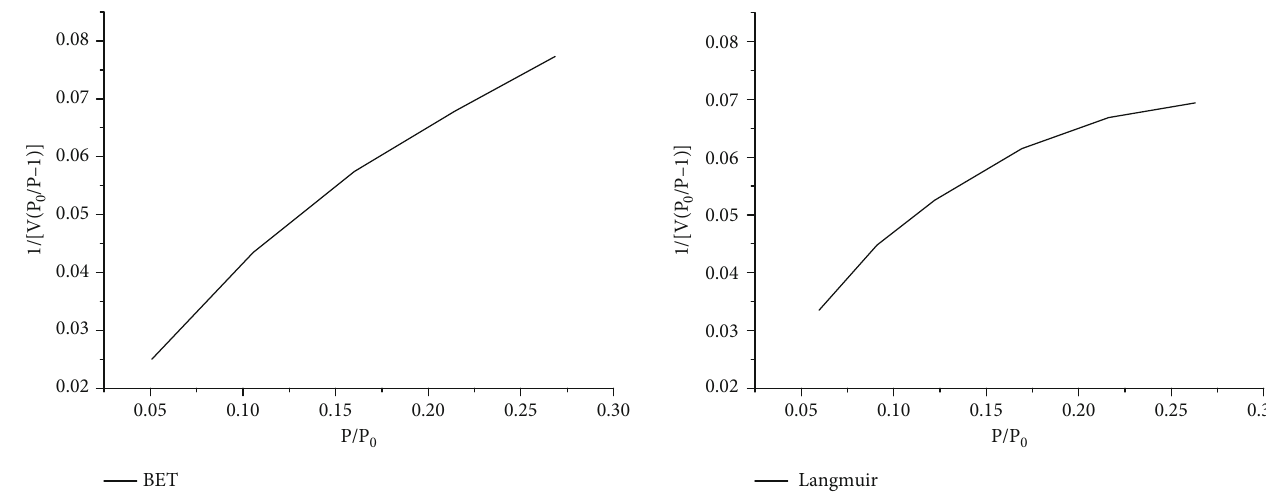
Figure 5: Speci fi c surface area measured by BET method and Langmuir